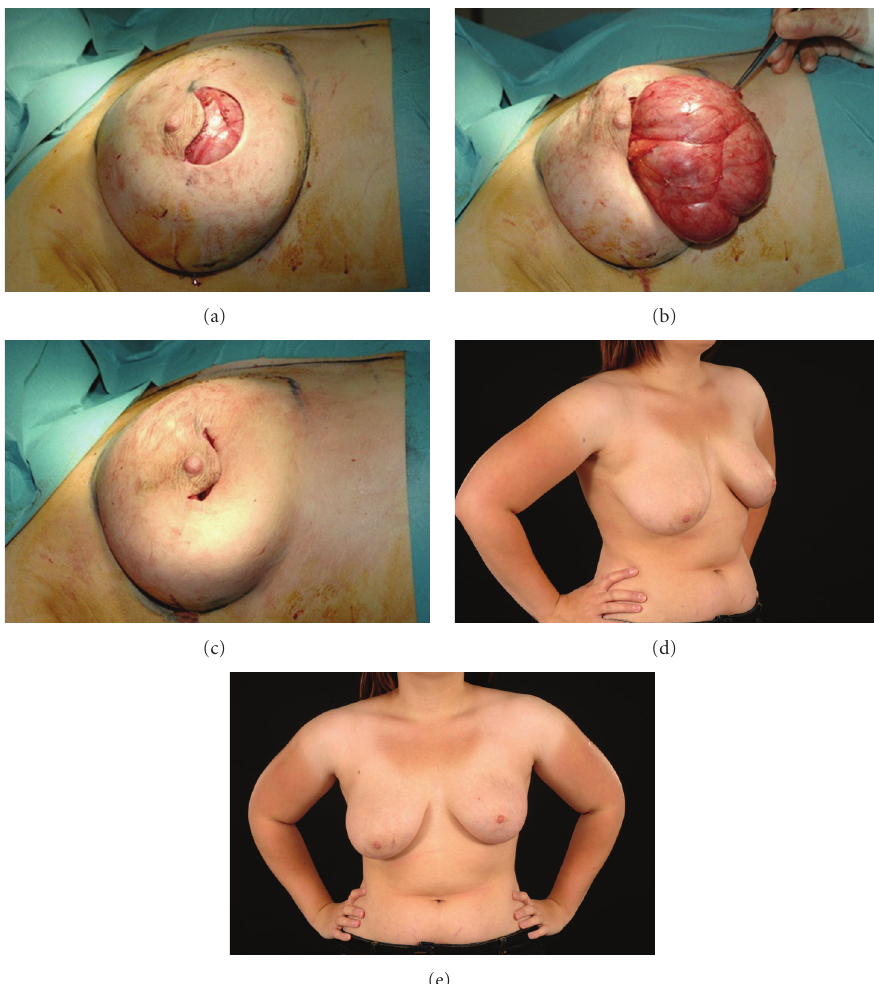
Figure 4: ((a),(b), and (c))Intraoperative pictures. (d) Postoperative pictures showthe good cosmetic results with slight asymmetry between both sides, reported by the patient as being her normal as before the PASH